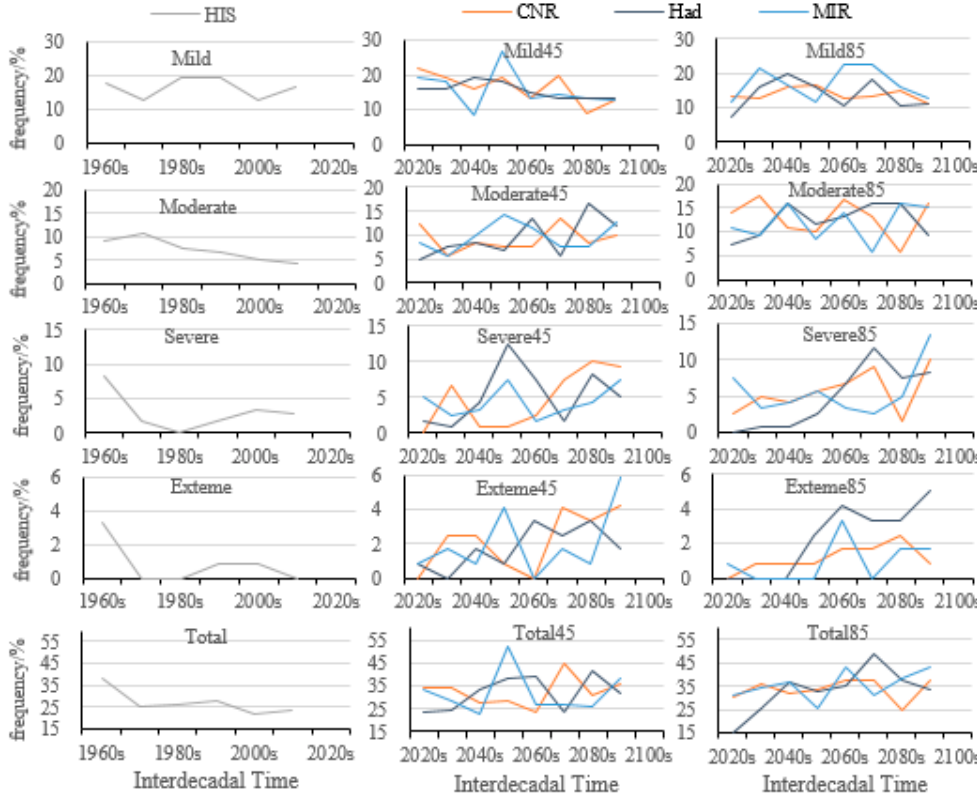
Figure 6. Interdecadal variation of drought frequency (%) at different drought categories historically (1960–2015) and in the future (2020–2099).